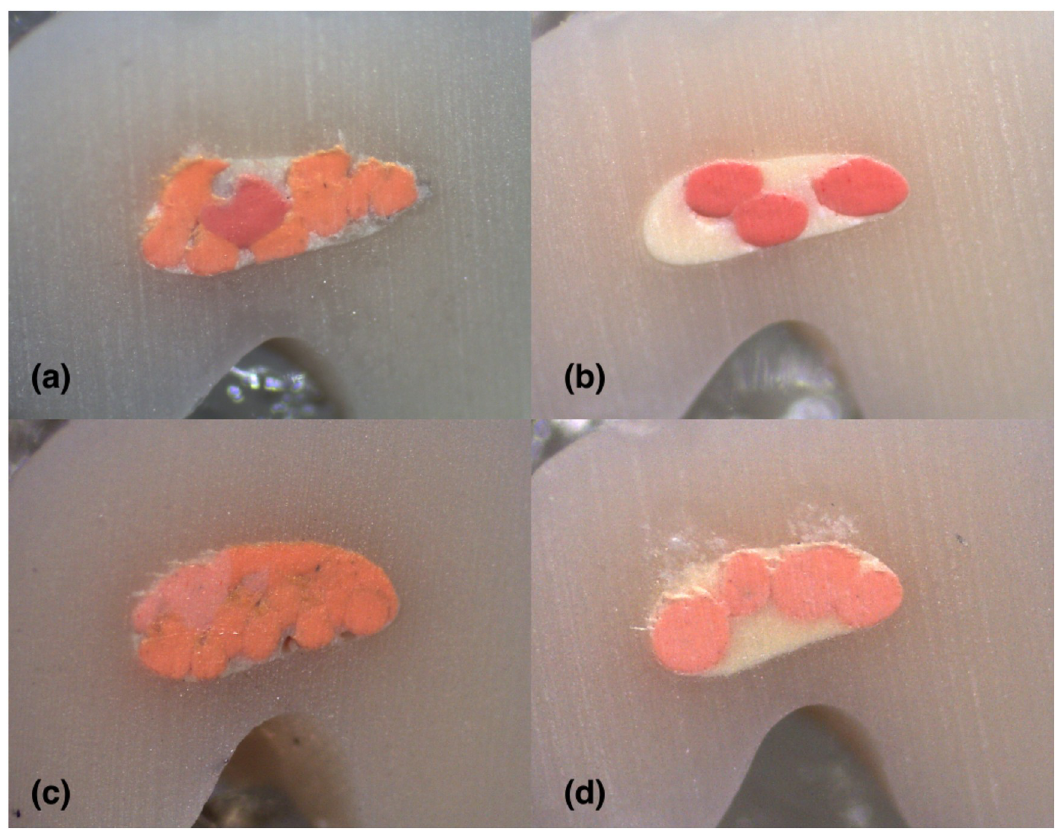
Fig 4. Stereomicroscope images of 2 mm sections instrumented with Hyflex EDM: (A) LC (B) CW; Stereomicroscope images of 2 mm sections instrumented with Reciproc Blue: (C) LC (D) CW in C1-type.